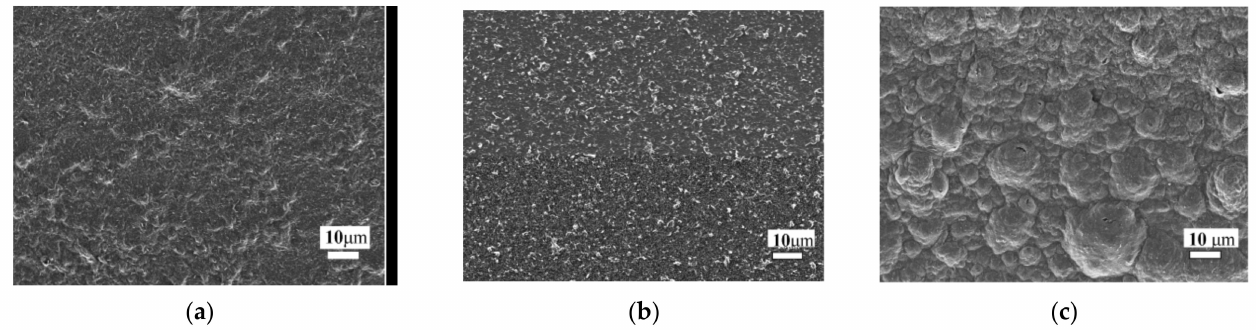
Figure 4. Scanning electron microscope images of MOG films before reduction ( a ), after thermal ( b ) and laser ( c ) reductions at × 1000 magnification.